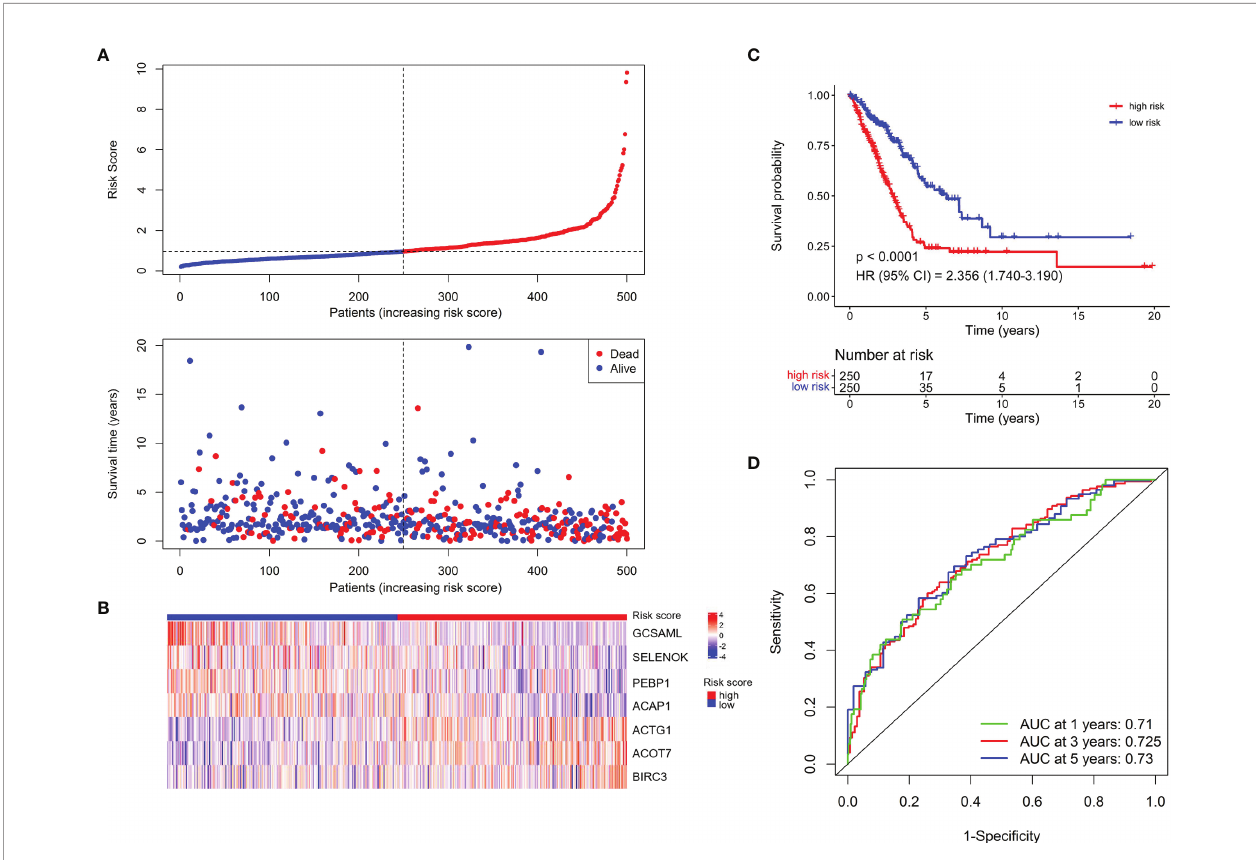
FIGURE 2 | Establishment of the NKCMGS in the TCGA LUAD cohort. (A) The distribution of risk score and survival status. (B) Heatmap showed the expression characteristics of the identi fi ed 7 NK cell marker genes. (C) Kaplan – Meier curves of survival analysis compared the overall survival of LUAD patients between high- risk and low-risk groups. (D) ROC curves of the NKCMGS for predicting the risk of death at 1, 3, and 5